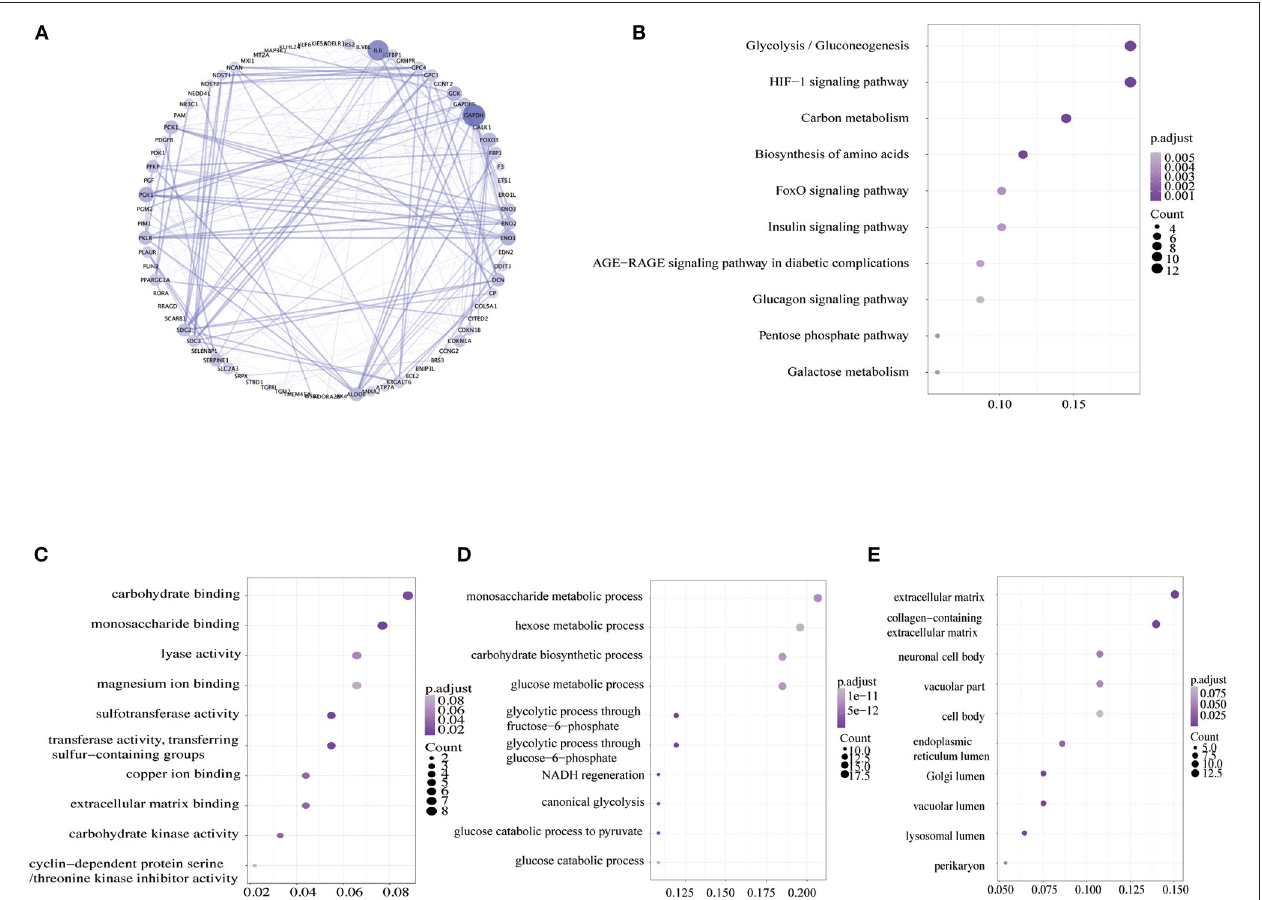
FIGURE 2 | Analysis of hypoxia-related genes. (A) PPI networks of hypoxia-related genes. A large node means a higher degree. (B) KEGG pathway enrichment analysis of hypoxia-related genes. (C–E) GO enrichment analysis of molecular function (MF), biological process (BP), and cellular component (CC). PPI, the protein–protein interaction; GO, Gene Ontology; KEGG, Kyoto Encyclopedia of Genes and